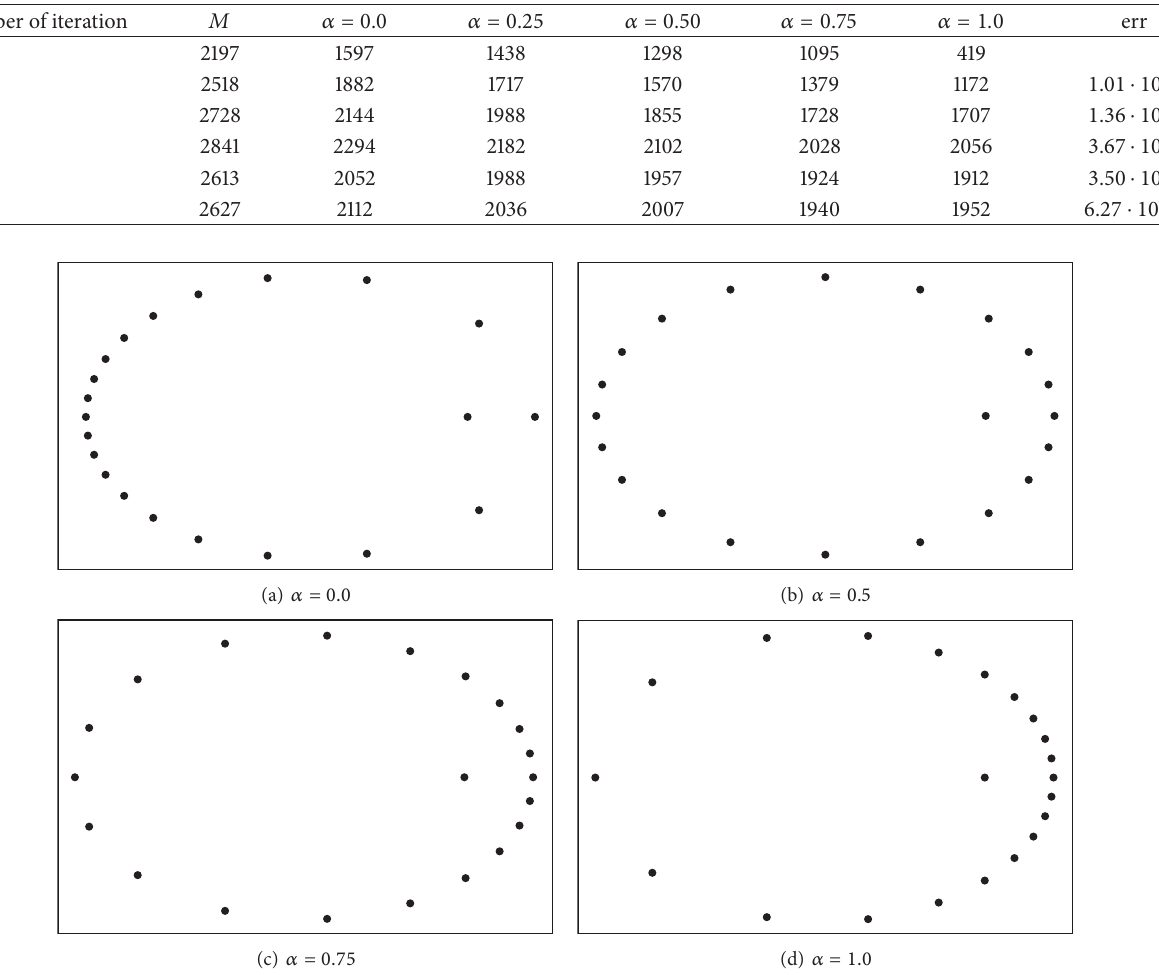
Figure 2: Points distribution for 𝑒 = 0.7 , 𝛼 = 0.0, 0.5, 0.75, 1.0 .